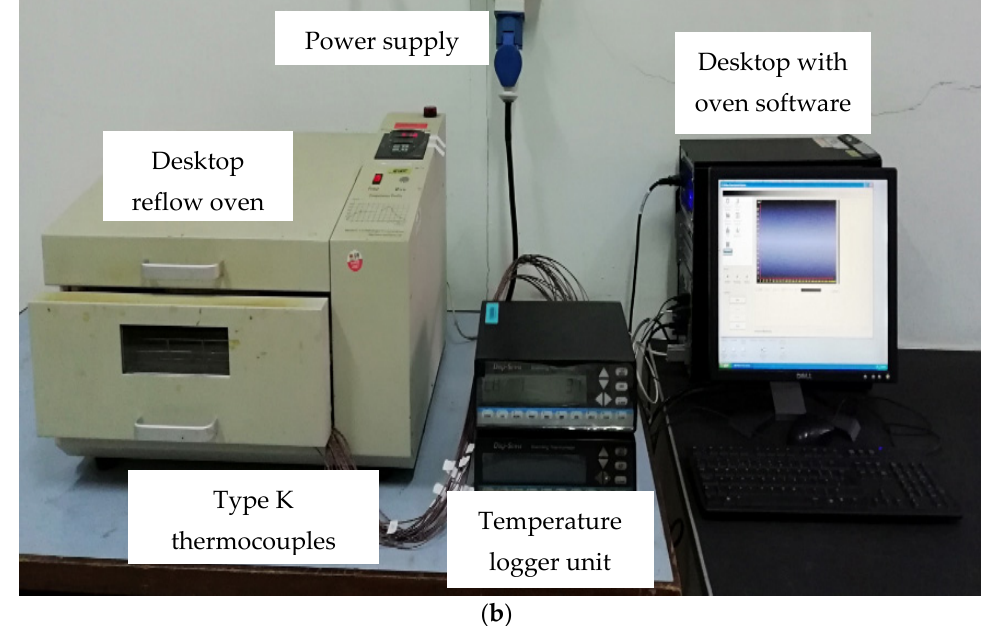
Figure 3. ( a ) Inner components and ( b ) overall setup of the desktop reflow oven.